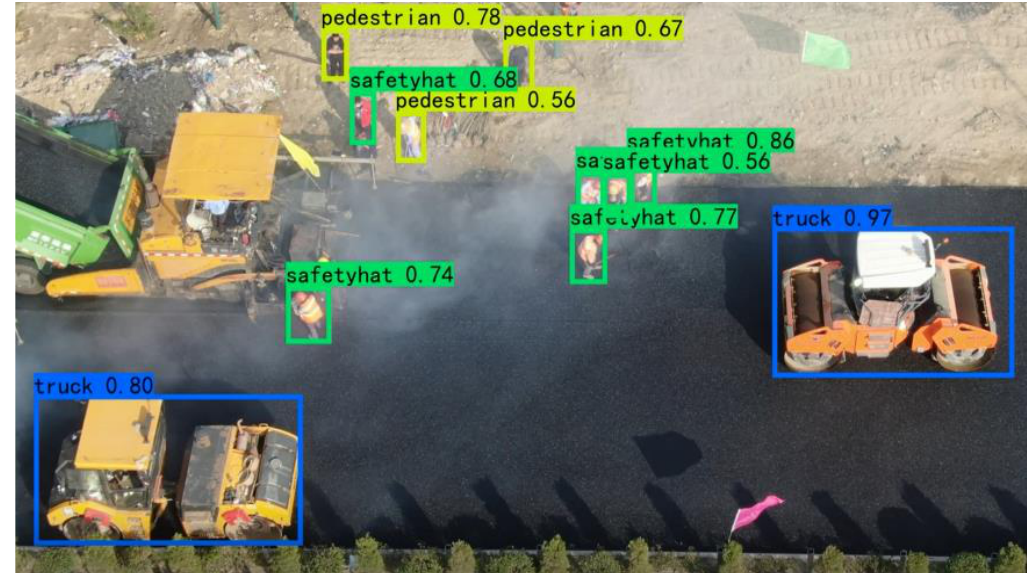
Figure 8. Monitoring of the road construction site.